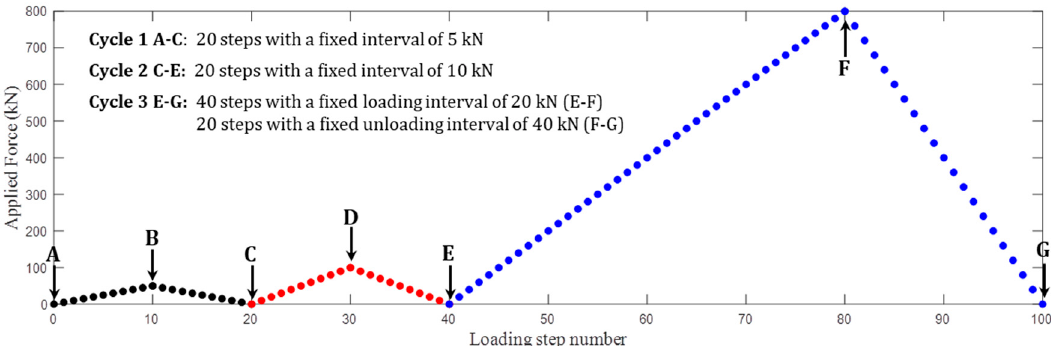
Figure 2. The loading-unloading steps conducted on each concrete sample.